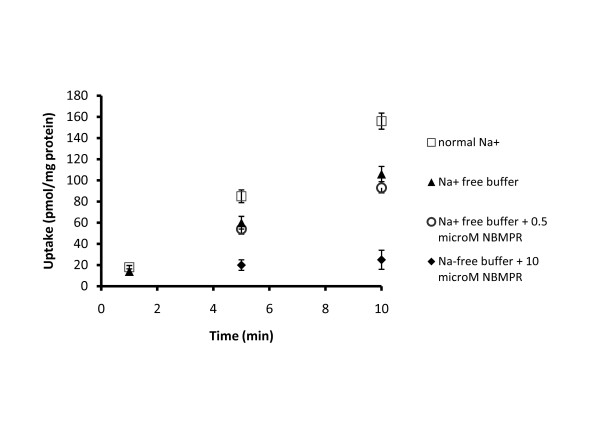
The uptake of [3H] inosine into human CP incubated in aCSF containing 139 mEq Na+ (squares), Na+-free aCSF medium (triangles), and Na+-free aCSF medium containing either 0.5 μM S-(4-Nitrobenzyl)-6-thioinosine (NBMPR) (circle) or 10 μM NBMPR (deltoid). The data are presented as means ± SEM from 3-4 separate experiments. The uptake values for inosine by CP tissue in aCSF (presence of Na+) after 5 and 10 min of incubation were significantly higher than the corresponding uptake values seen in Na+-free aCSF (p < 0.01). Uptake of inosine after 5 min (n = 3) and 10 min (n = 3) of incubation in the presence of 0.5 μM NBMPR in Na+-free aCSF did not differ significantly from the corresponding uptake after incubation in Na+-free aCSF which did not contain NBMPR (p > 0.05). The presence of 10 μM NBMPR in Na+-free aCSF caused significant inhibition of inosine uptake after 5 min (n = 4, p < 0.01) and after 10 min (n = 3, p < 0.001), when compared to the uptake in Na+-free aCSF which did not contain NBMPR.